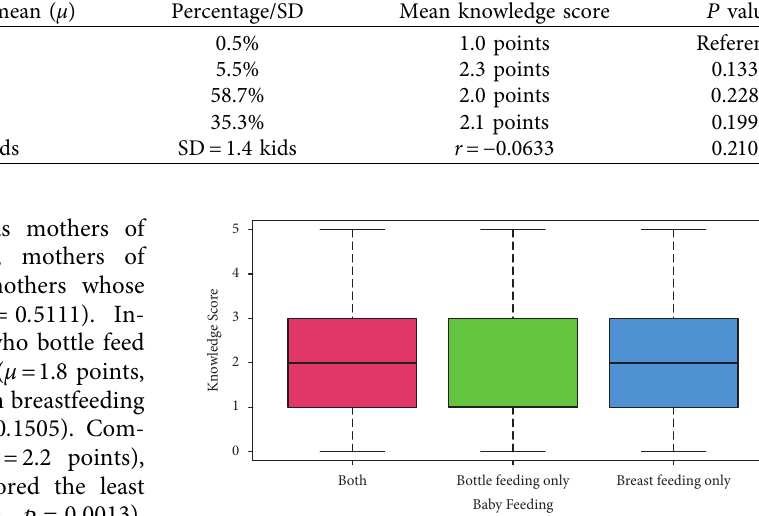
Figure 1: Mothers who bottle feed their babies ( n � 103, 26.8%) scored far less ( μ � 1.8 points, p � 0 . 0013) in terms of knowledge score than breastfeeding women ( n � 95, 24.7%, μ � 2.0 points, p � 0 .